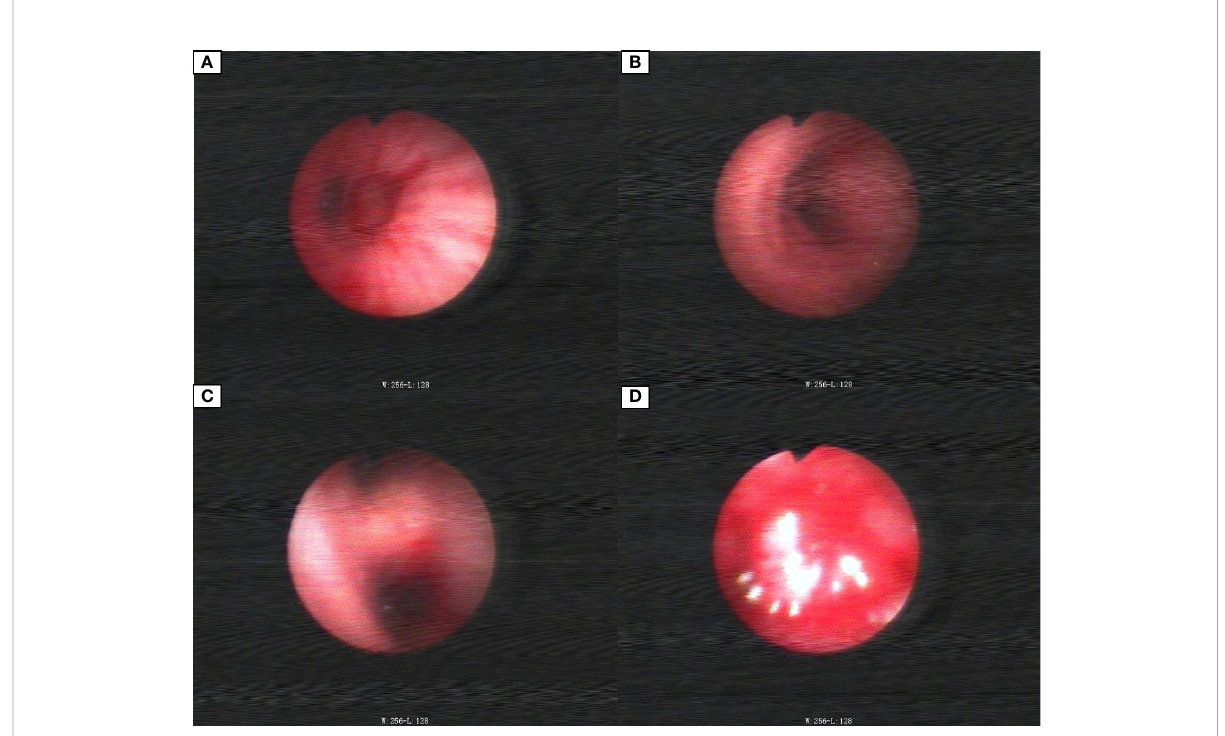
FIGURE 3 Bronchoscopic images. (A) Middle bronchial tubes. (B) Right main stem bronchi. (C) Right middle lobe bronchial. (D) Right lower lobe bronchial